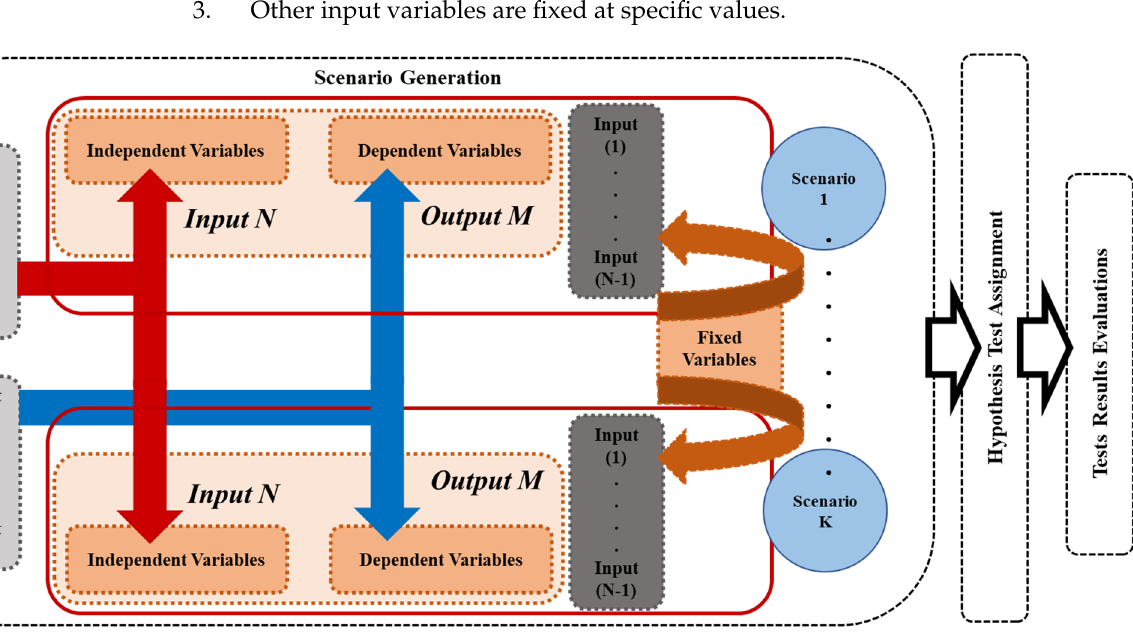
Figure 4. Stage 2 of the